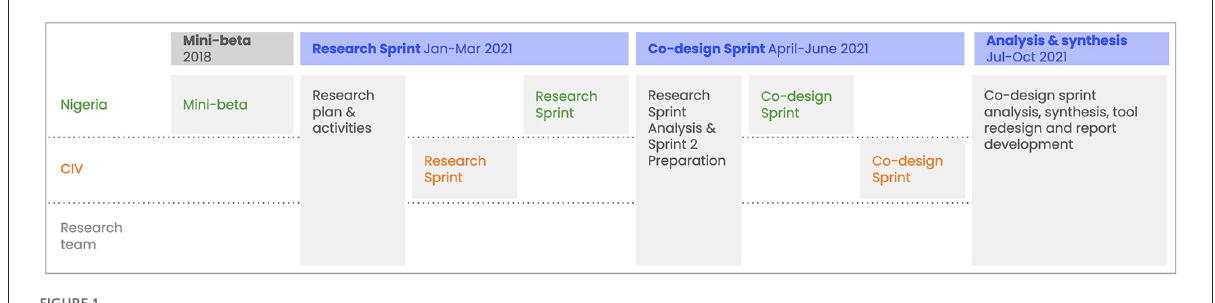
FIGURE1 Health facility labs, overall approach and